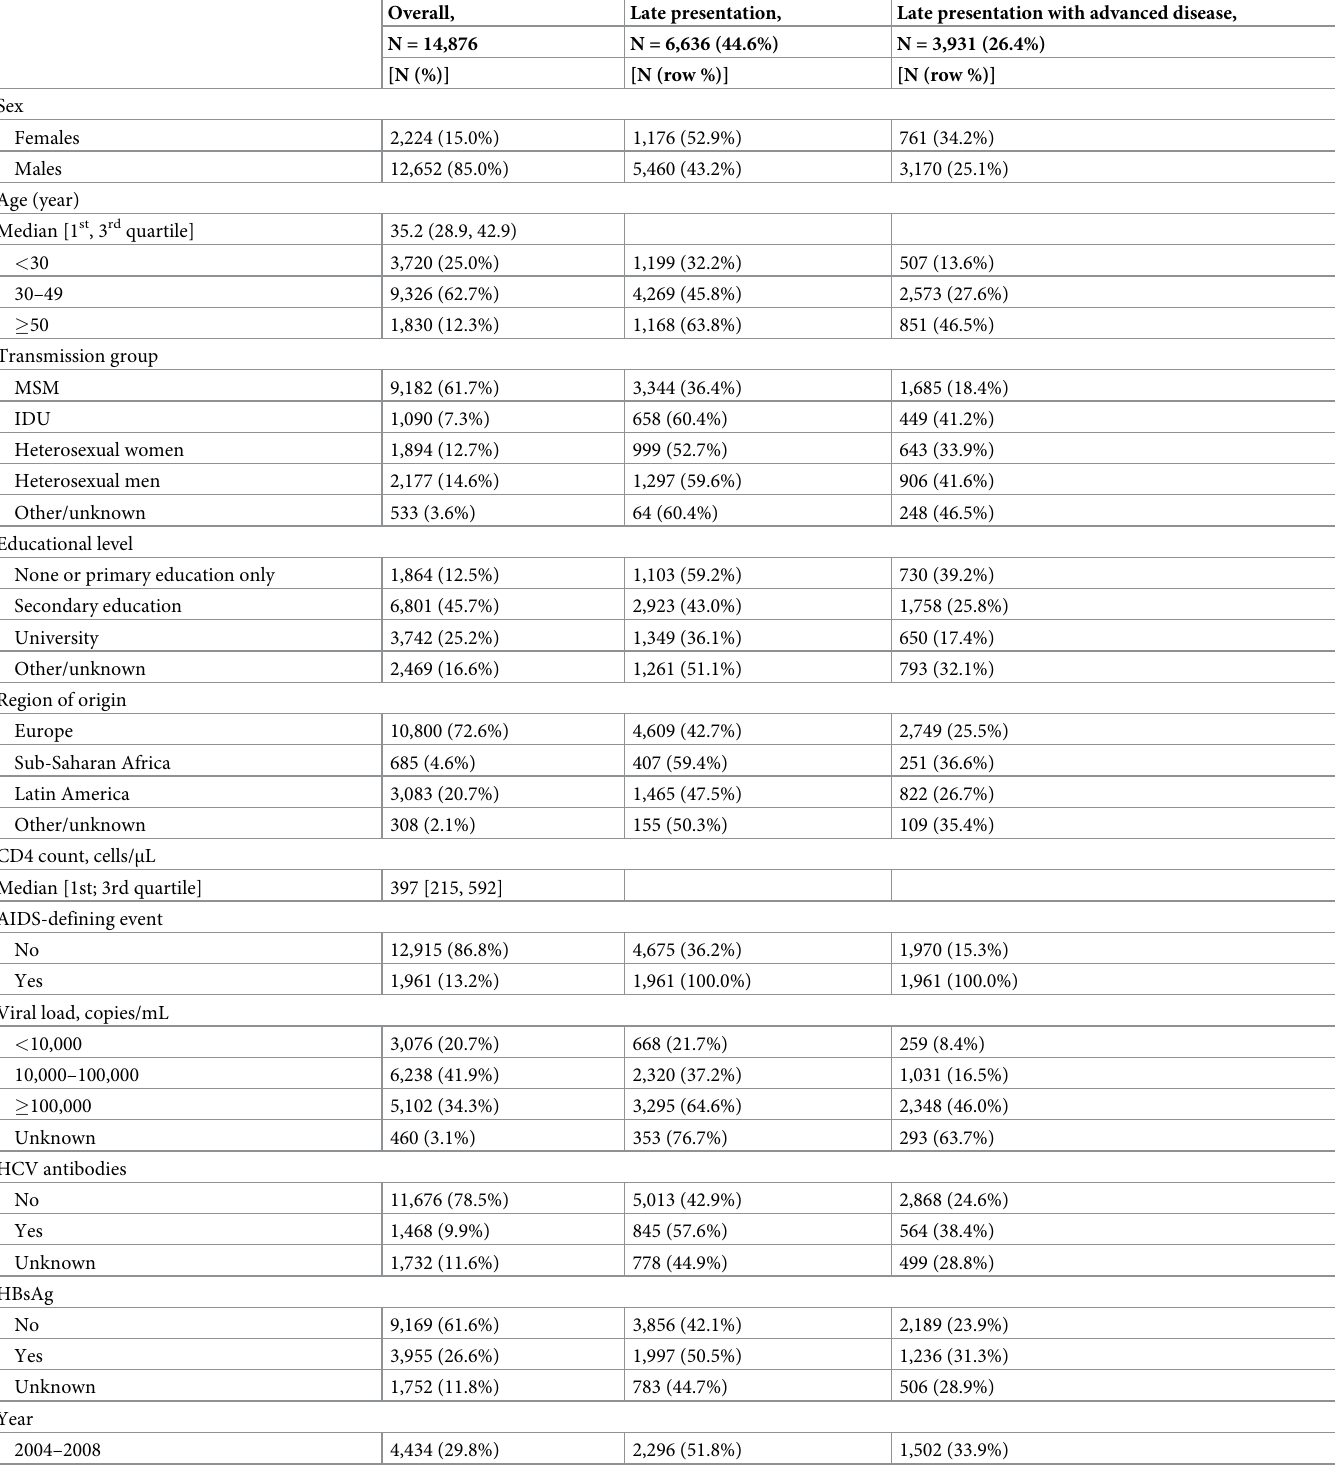
Table 1. Sociodemographic and clinical characteristics of the participants included, and prevalence of late presentation and late presentation with advanced disease according to their characteristics at enrolment, Spain, 2004–2018 (n = 14,876). Overall, Late